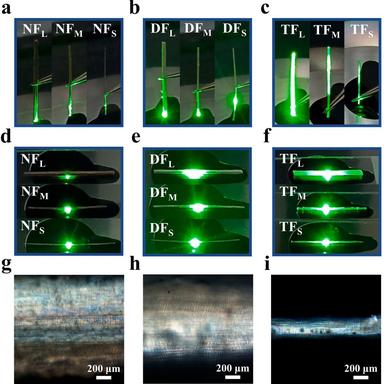
Photographs of one end of (a) natural fibers, (b) delignified fibers, and (c) transparent fibers irradiated by a green laser. Photographs of the midpoint of (d) natural fibers, (e) delignified fibers, and (f) transparent fibers irradiated by a green laser. Polarized light microscopy images of (g) TFL, (h) TFM and (i) TFS. (For interpretation of the references to color in this figure legend, the reader is referred to the web version of this article.)